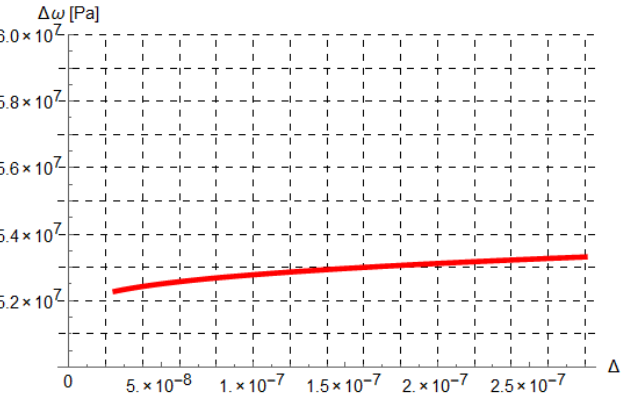
Figure 6. The course of absolute pressure loss ∆ ω , as a function of surface roughness ∆ .